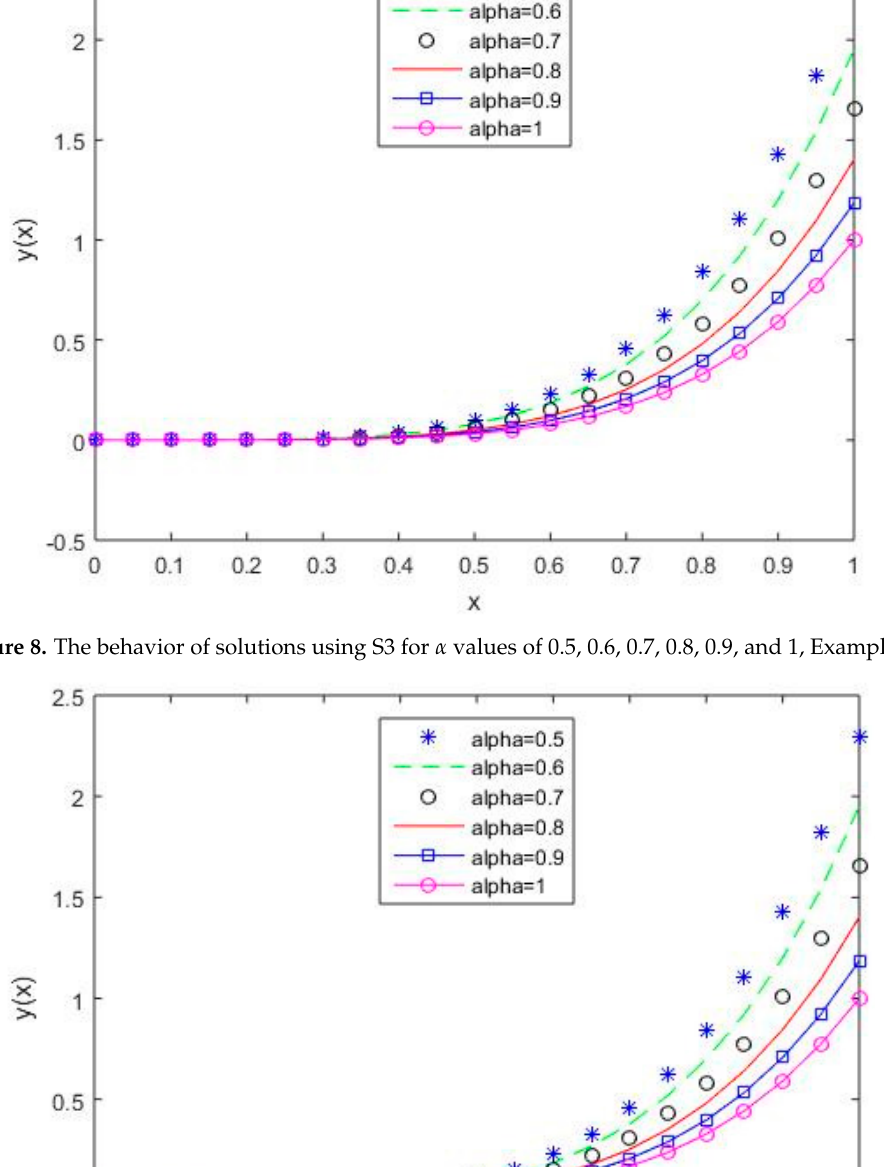
Figure 7. The behavior of solutions using S2 for 𝛼 values of 0.5,0.6,0.7, 0.8,0.9, and 1 , Example 1.